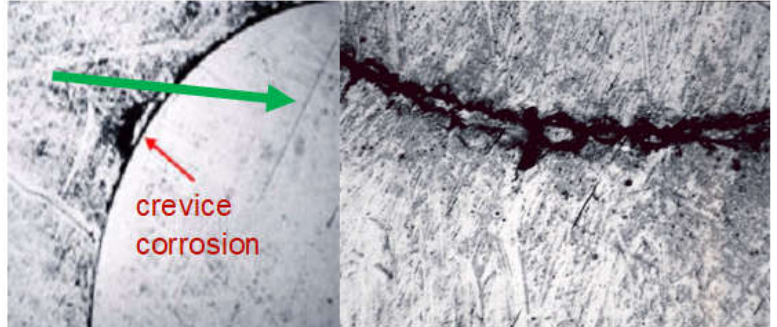
Figure 30. Corrosion aspect at the link/smooth driven pin interface. Optical examination, magnification 10×. Optical examination, magnification 5×. Link sample #7 and pin sample #3.